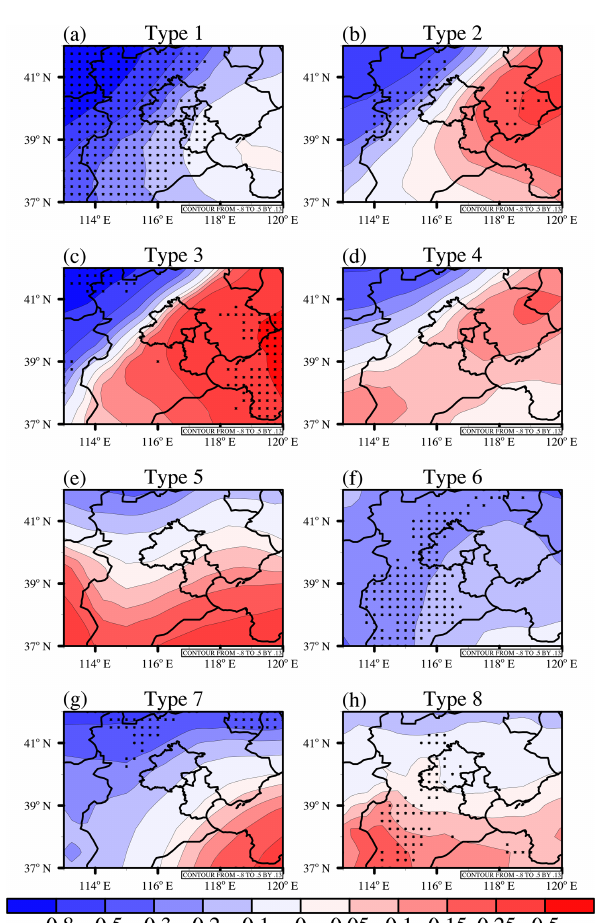
Figure 5. Changes in SLP over the JJJ region under eight circulation types in the EP El Niño years relative to the climatological means (unit: hPa). The dots indicate that the differences between more than 60% of ensemble member pairs have the same sign as the mean differences.